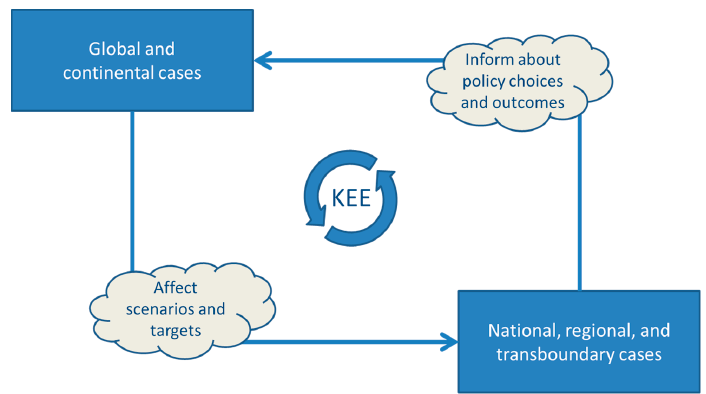
Figure 7. Feedback across spatial scales facilitated by the Knowledge Elicitation Engine (KEE).